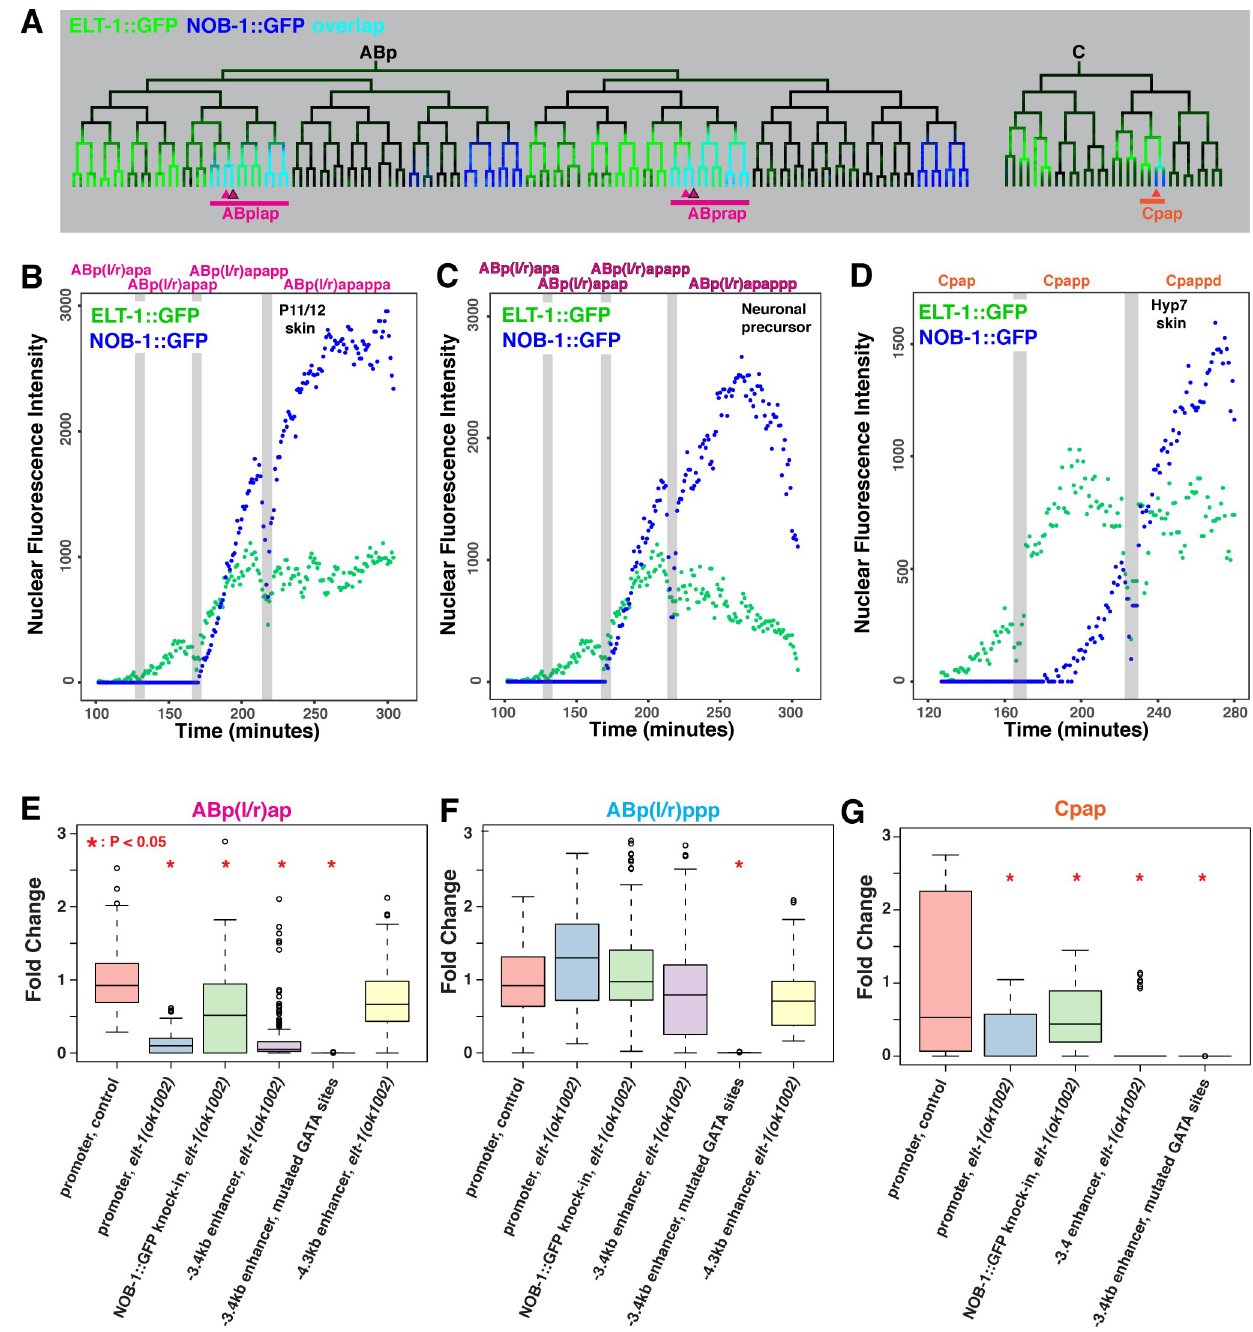
Fig 5. elt-1 regulates nob-1 expression in ABp(l/r)ap lineage. A) Partial lineage trees showing transgene expression patterns of ELT-1::GFP (green), NOB- 1::GFP (blue) or overlapping (Cyan) expression in the ABp and C lineages. Arrowheads indicate branches shown in subsequent panels. B-D) Average transgenic ELT-1::GFP and NOB-1::GFP nuclear fluorescence intensity (arbitrary units) in cells leading to B) ABp(l/r)apappa (P11/12 blast, part of the ventral hypodermis in the embryo) C), ABp(l/r)apappp (neuroblast fate), and D) Cpappd (hypodermal fate). Grey bars mark cell divisions. E-G) Fold change values for the nob-1 promoter, endogenously tagged NOB-1::GFP, and -3.4 kb and -4.3 kb wild-type or mutated enhancer reporters in the ABp(l/r) ap lineage in the control and elt-1(ok1002) mutant conditions in the E) ABp(l/r)ap, F) ABp(l/r)ppp, and G) Cpap lineages. Number of biological replicates ranges from 4–6. Significant changes (p < 0.05) marked by red asterisk; P values determined by Wilcoxon Ranked Sum